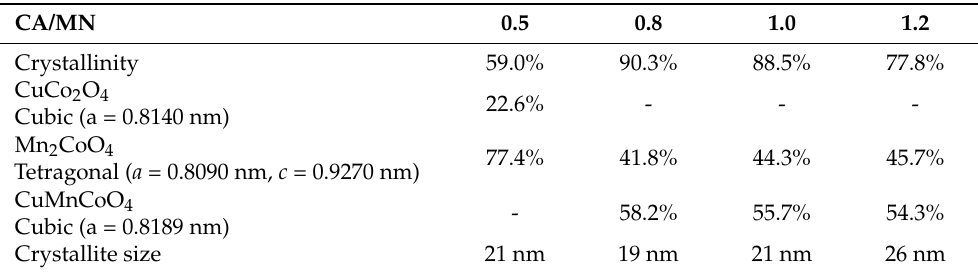
Table 1. Degree of crystallinity, the percentage of each constituent phase, and the crystallite size of the spinel powders synthesized at different CA/MN